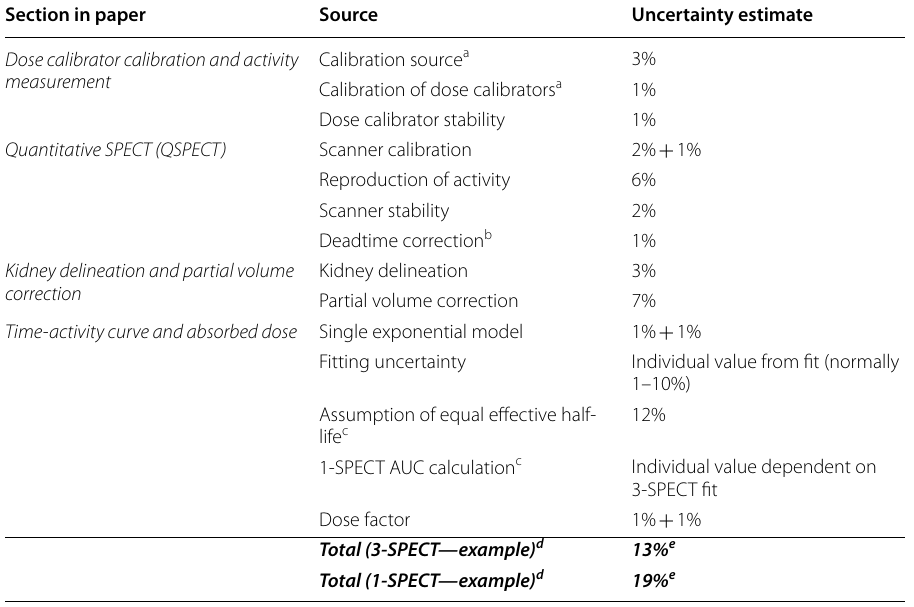
Table 2 Uncertainty budget for the dosimetry